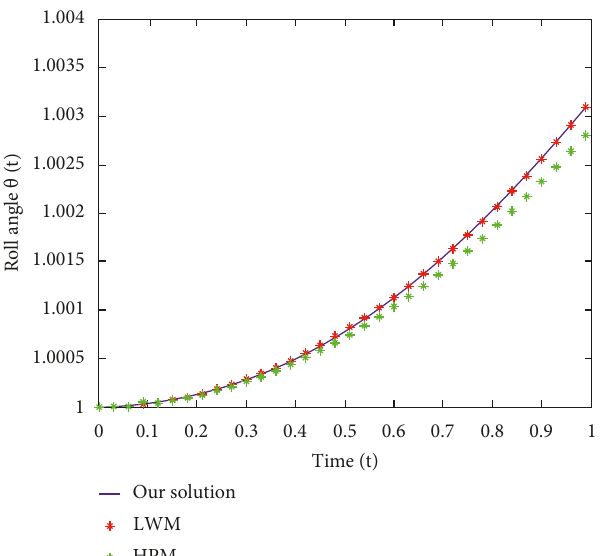
Figure 5: Comparative Study of Genocchi polynomial, LWM, and HPM for roll angle with respect to the time t (in sec) for Ex.5.